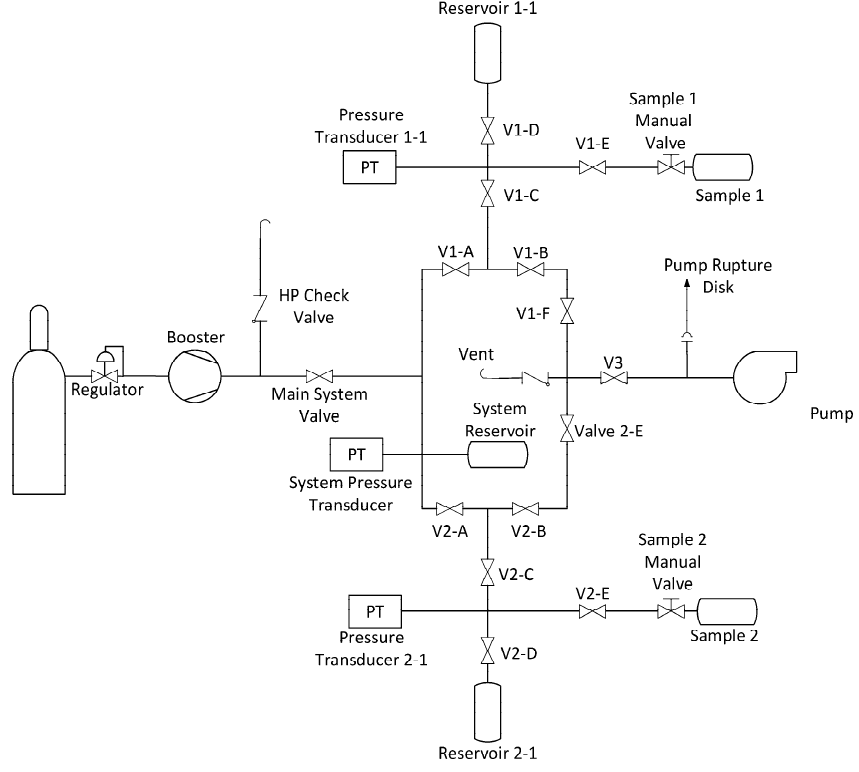
Figure 6. Schematic rendering of a two-channel high-pressure Sieverts’ apparatus for characterization of prototype-scale metal hydride materials. The valves in the apparatus are indicated with ‘V’